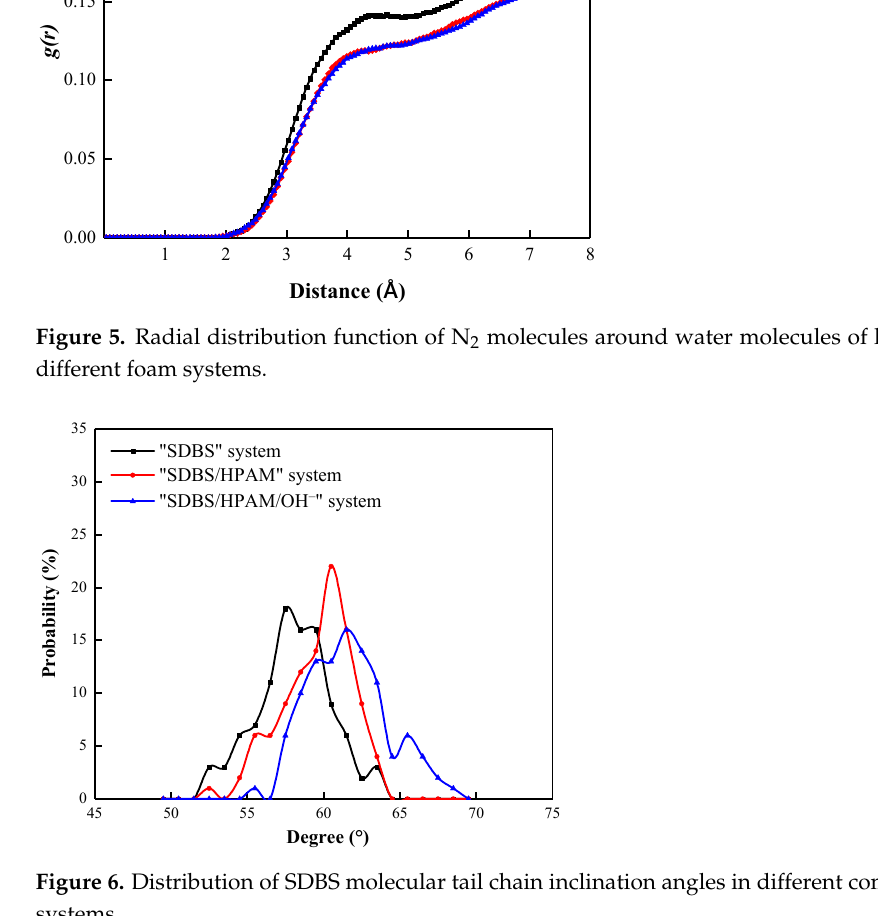
Figure 6. Distribution of SDBS molecular tail chain inclination angles in different component foam systems.